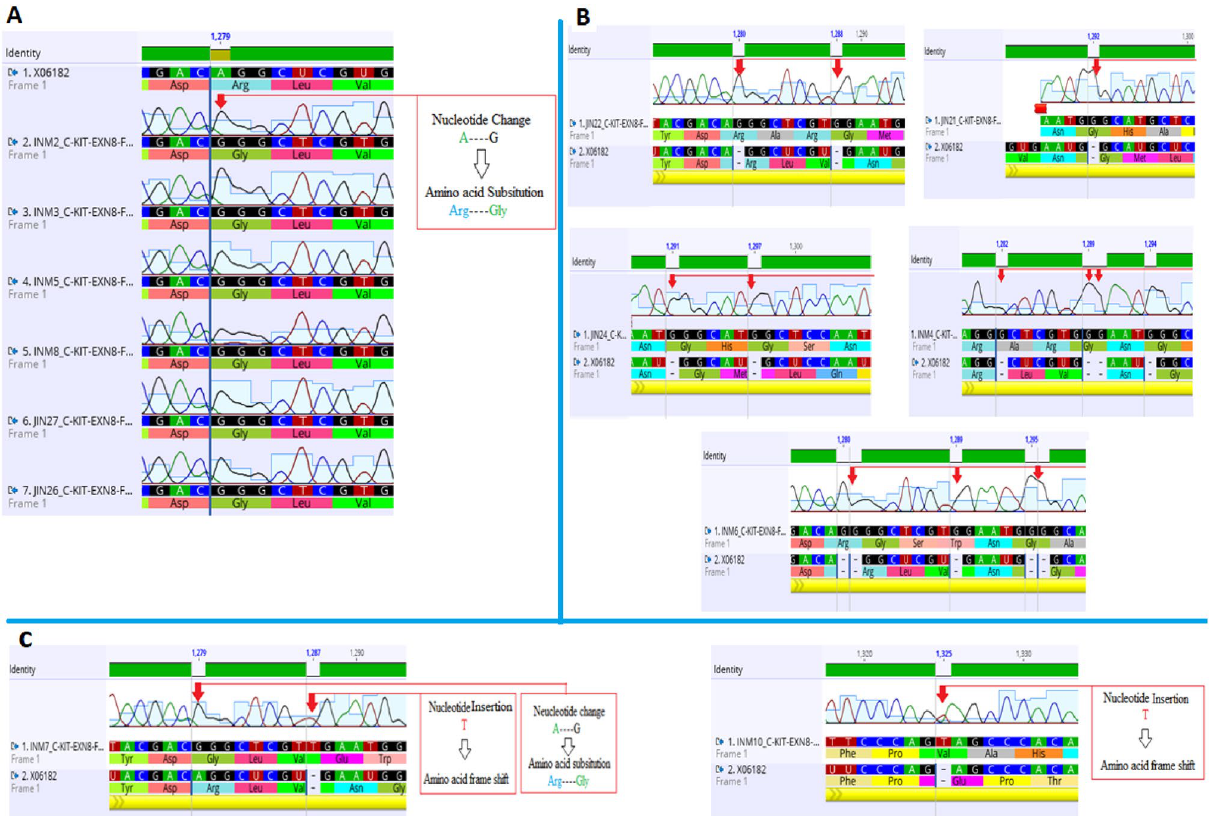
Figure 2. Electropherograms showing alignment of c-kit exon 8 in AML patient sequences against NCBI GenBank accession number: X06182.1. Multiple alignment of patient sequences (n = 9) harboring nucleotide substitution 1279 A > G resulting in Arg420Gly ( A ). Insertion of nucleotide Guanine (G) at different positions in different individuals (n = 05) as a result frame of translating amino acid is shifted ( B ). Substitution 1279 A > G